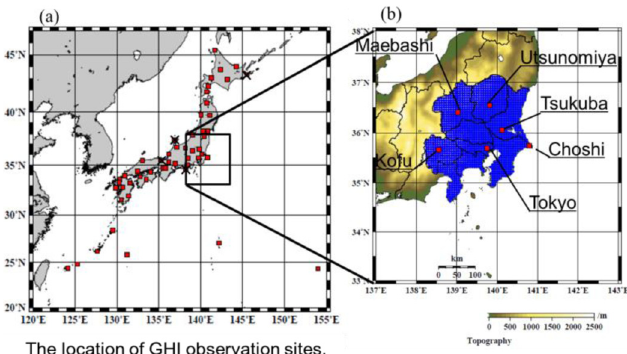
Fig. 1. (a) Map of Japan area and (b) close-up view of the Tokyo electric power area (TEPCO). Red squares and blue dots mean the JMA observations and the locations of MSM model grids within TEPCO area,